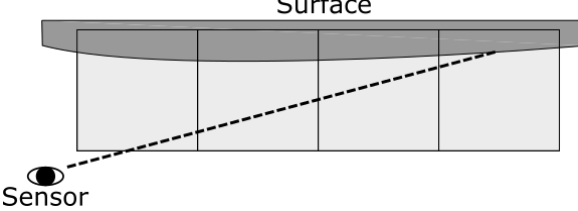
Figure 9. A ray may traverse other voxels assumed to be solid before hitting a surface, thereby successively changing their state to free.